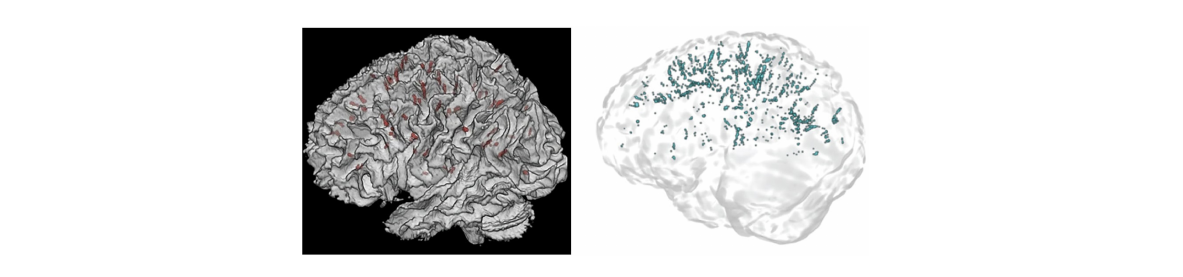
FIGURE11 3D renders of PVS segmentations in astronauts from Hupfeld et al. (2022) (left) and Barisano et al. (2022b) (right) . On the left, PVS are displayed in red, whilst on the right PVS are blue. Reproduced under the Creative Commons Attribution 4.0 International License